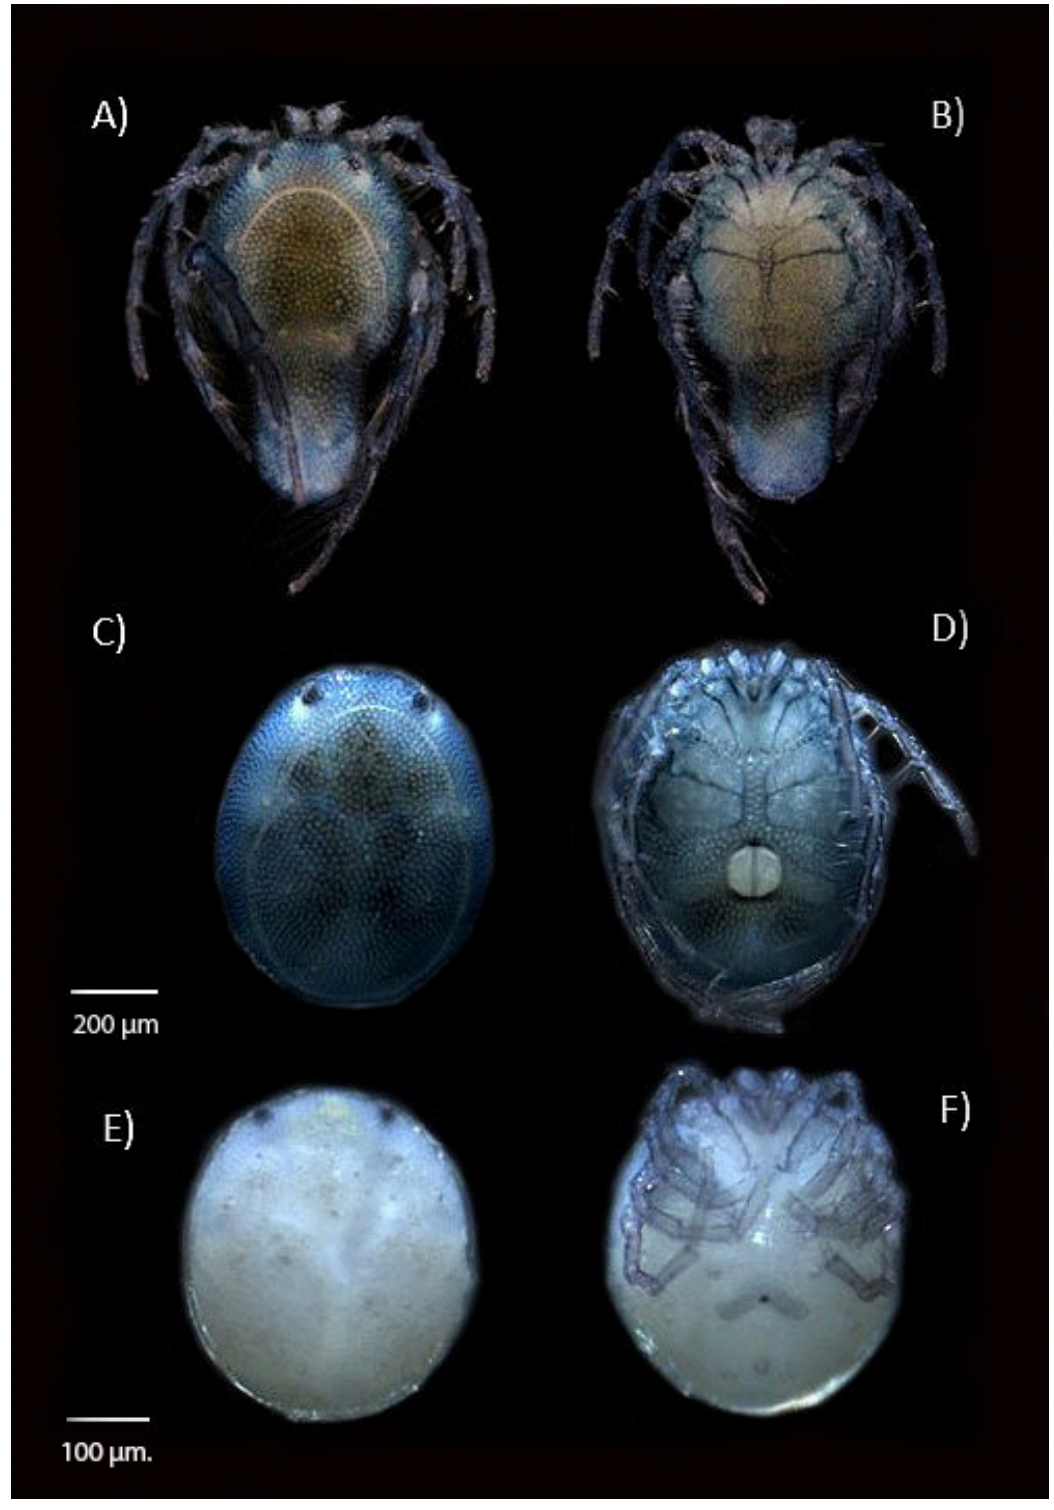
Figure 5. Arrenurus sp. BIN ACX8463: ( A , B ) dorsal and ventral view of male, ( C , D ) dorsal and ventral view of female, and ( E , F ) dorsal and ventral view of nymph.